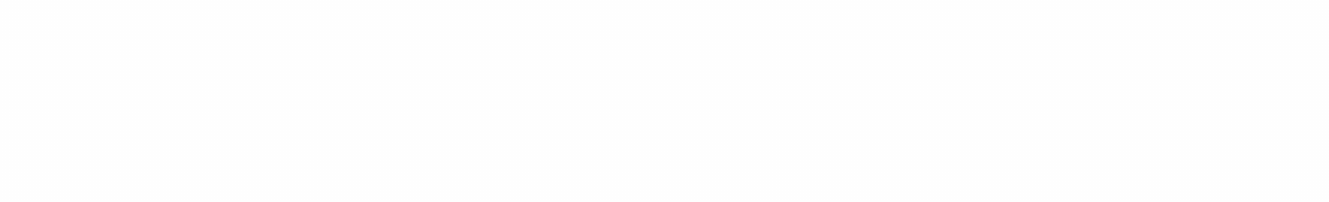
tion of the principle of an oscillator expanding Eq. (I) taken at